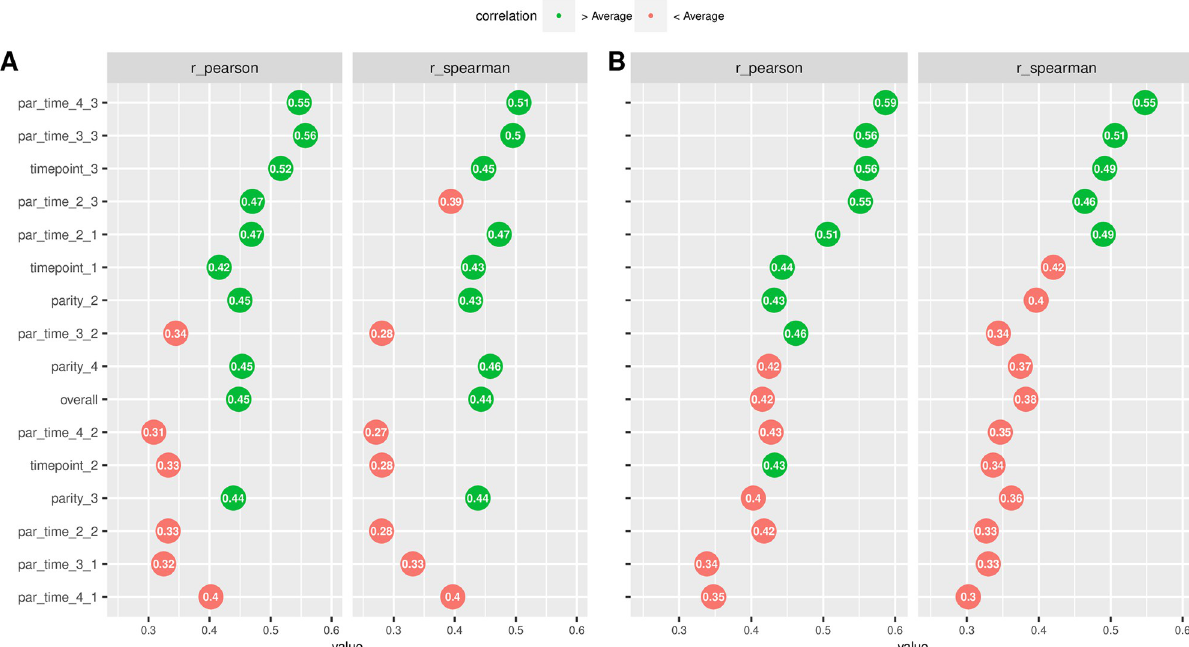
Fig 1. Raw and model-based correlations. A) raw correlations (Pearson, left and Spearman (rank), right) between log (SCC) and DSCC. B) model- based correlations (Pearson, left and Spearman (rank), right) between log (SCC) and DSCC. Overall (whole dataset) and stratified (parity, timepoint, and timepoint-by-parity: e.g., par_time_2_3 indicates parity 2 and timepoint T3) correlations. Green and red colors indicate whether specific correlations are above or below average.